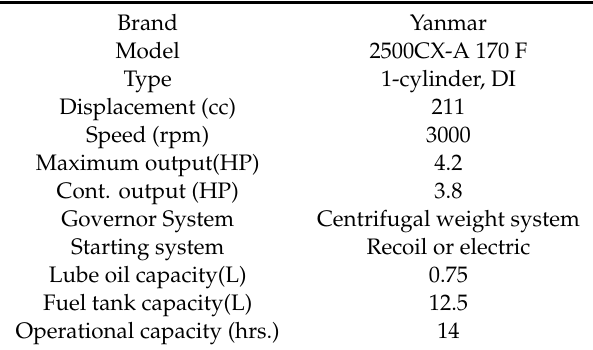
Table 1. Diesel engine technical